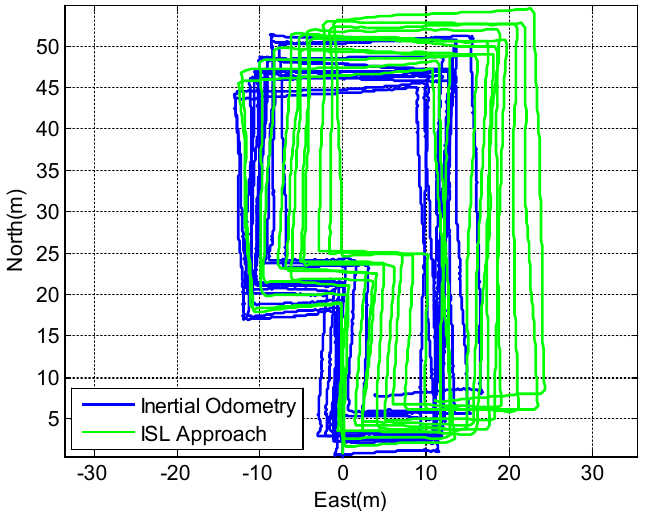
Figure 7. Positioning comparison of ISL and inertial odometry.